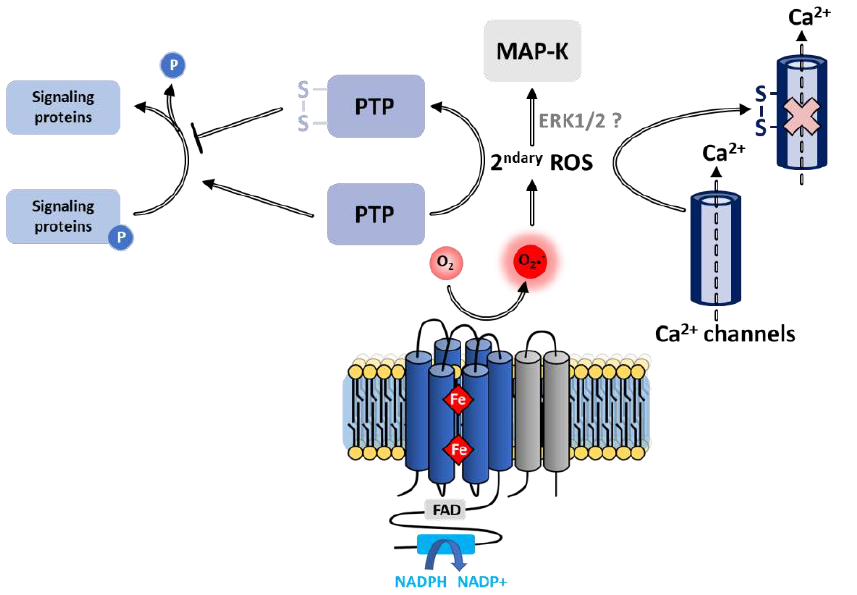
Figure 16. Regulation of phosphatase, kinase and calcium channel signaling pathways by NOX. The NOX-mediated production of superoxide and resulting secondary ROS leads to the oxidation of cysteines on PTPs [295] and calcium channels, resulting in the formation of disulfide bridges. PTP activity opposes that of kinases, thus regulating a large number of proteins involved in a variety of signaling pathways; PTP activity also regulates Ca 2+ ion flux. Secondary ROS can also activate MAP-Ks, possibly via the ERK1/2 signaling pathway through activation of epidermal growth factor (EGF) receptors, and platelet-derived growth factor (PDGF) receptors, which can stimulate Ras and the subsequent activation of the ERK pathway [296].